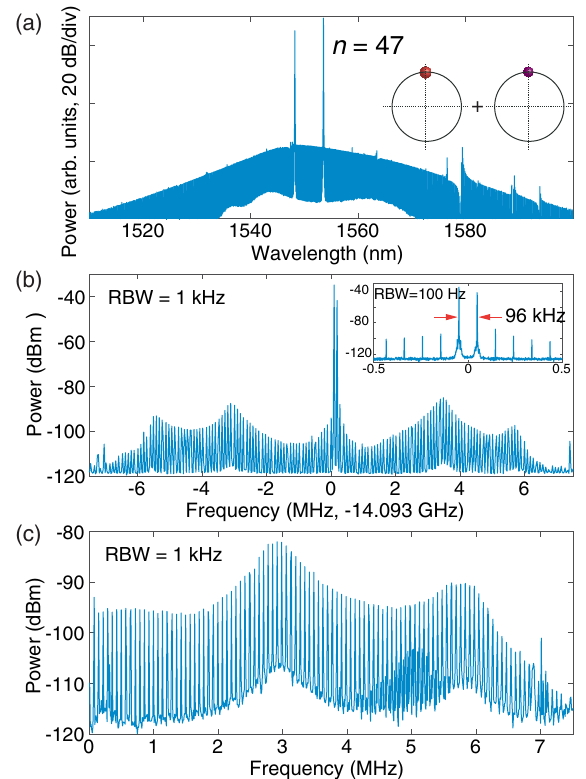
FIG. 4. Observation of soliton collisions. (a) Optical spectrum of the coexistence of a primary soliton and a secondary soliton. (b) The spectrum of the repetition rates of solitons. The inset shows the two prominent spectral peaks with a frequency difference of 96 kHz. There are also multiple sidebands with equal frequency separations that are generated by the collisions. (c) The spectrum of the output soliton power at low-frequency ranges. The overall shape resembles that of the sidebands around the repetition rates, having two peaks around 3 and 5.7 MHz which we attribute to the peaks around the S -resonance frequen- cies in the noise transfer function [67] in a modulated DKS